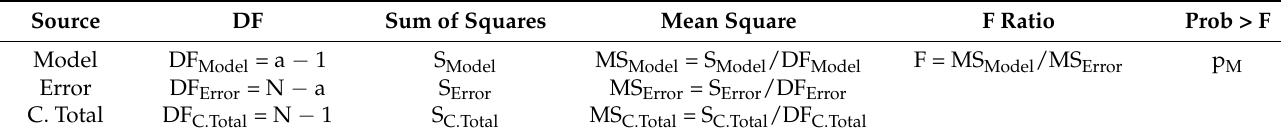
Table 3. Basic analysis of an